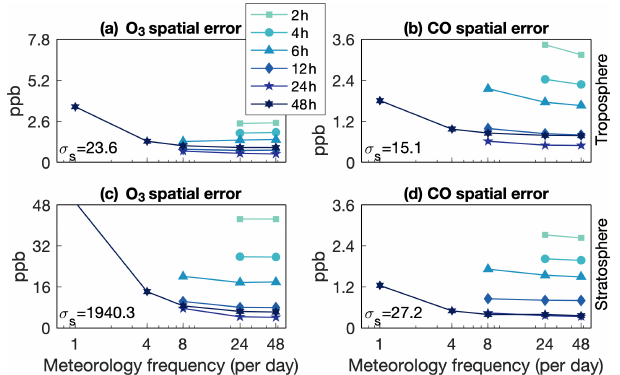
Figure 8. As in Fig. 7 but for the root-mean-square spatial error, and the globally and vertically averaged spatial standard deviation of each field is shown in each panel.